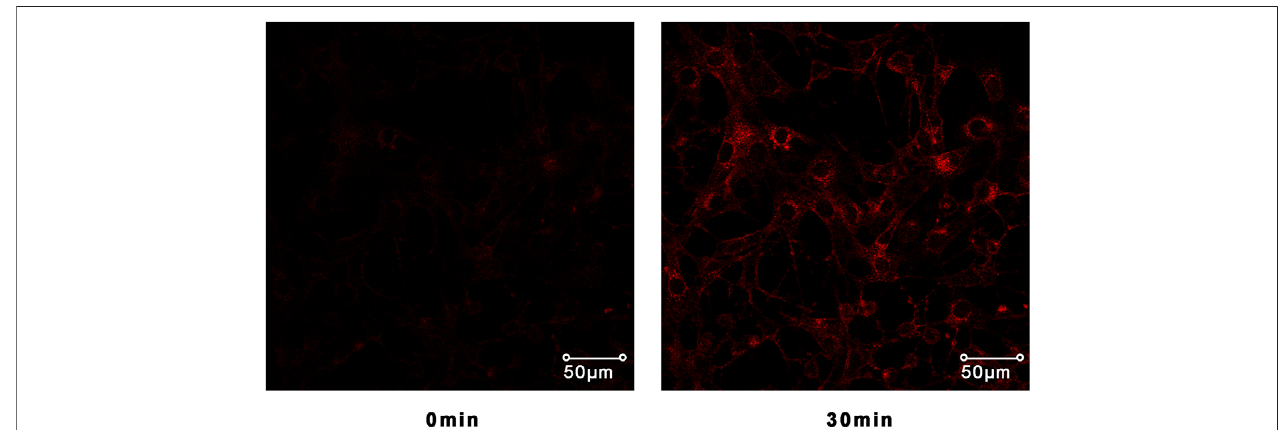
FIGURE 7 | Confocal microscope was used to track IRAP fl uorescence changes in L6 cells. L6 cells exposed to the compound 5 for 30 min could signi fi cantly induce IRAP fl uorescence enhancement.